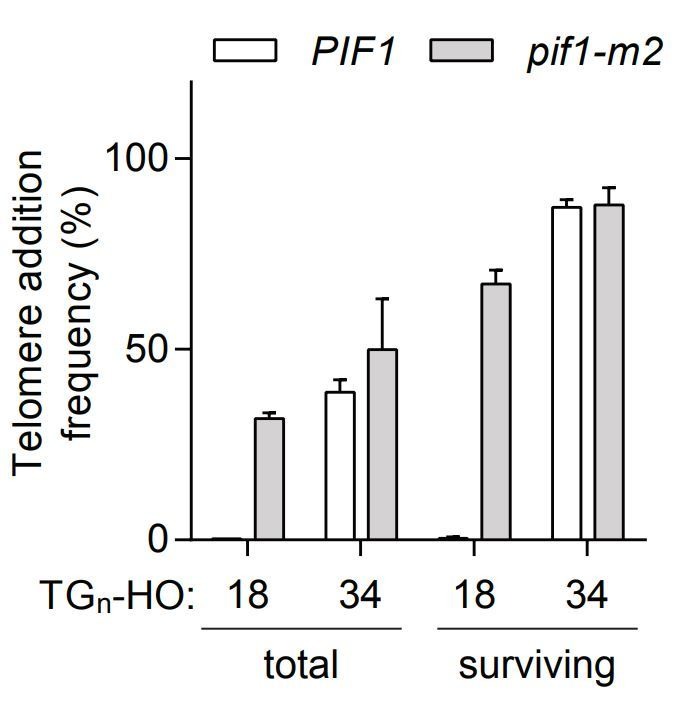
Telomere addition frequency at DNA ends containing 18 or 34 bp of TG sequence normalized either to the total amount of cells (total) or only the surviving cells after the 4h galactose induction (surviving).Data represent the mean ± s.d. from a minimum of n=3 independent experiments.